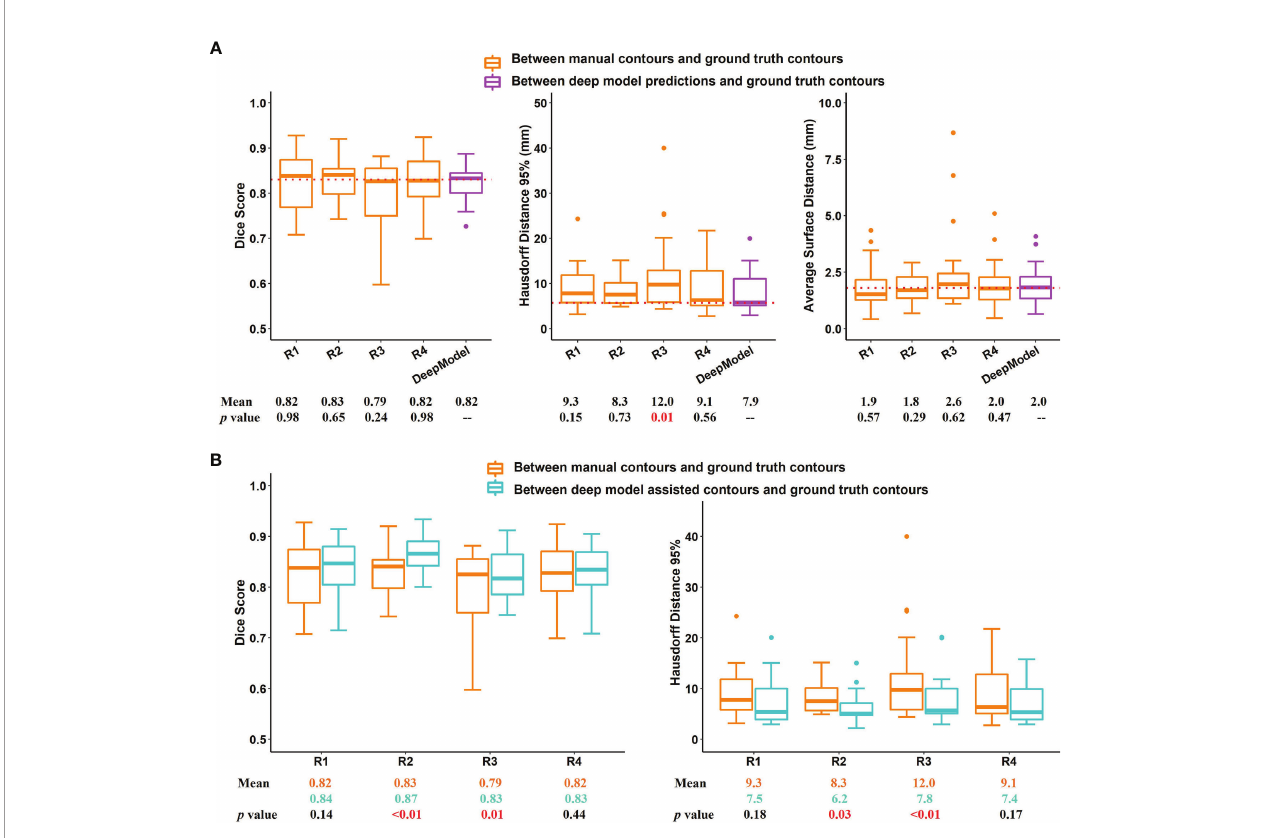
FIGURE 5 | Results of multi-user evaluation. (A) Boxplot of Dice similarity coef fi cient (DSC), 95% Hausdorff distance (HD95), and average surface distance (ASD) for the comparison of manual contours of four radiation oncologists with our treatment planning CT (pCT)-based deep model-predicted contours. Dotted lines indicate the median DSC, HD95, and ASD of our pCT model performance. (B) Comparison of DSC and HD95 between second-time deep learning-assisted contours with those of fi rst-time manual contours. R1 to R4 represent the 4 radiation oncologists involved in the multi-user evaluation. DeepModel is our pCT